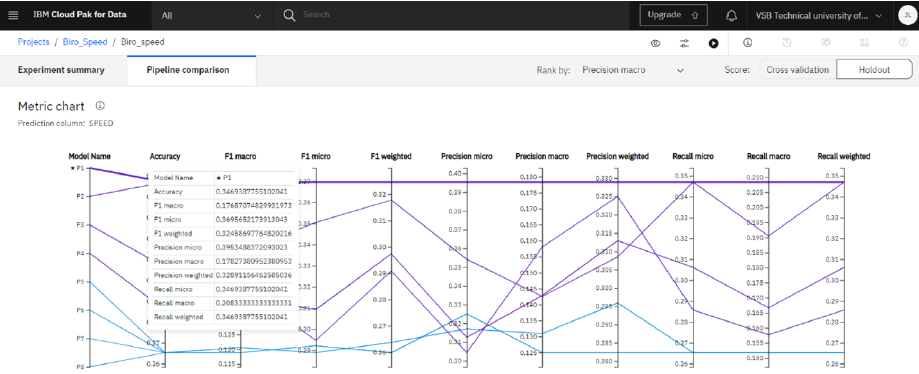
Figure 21. Algorithm comparision (P1 is XGB classifier).